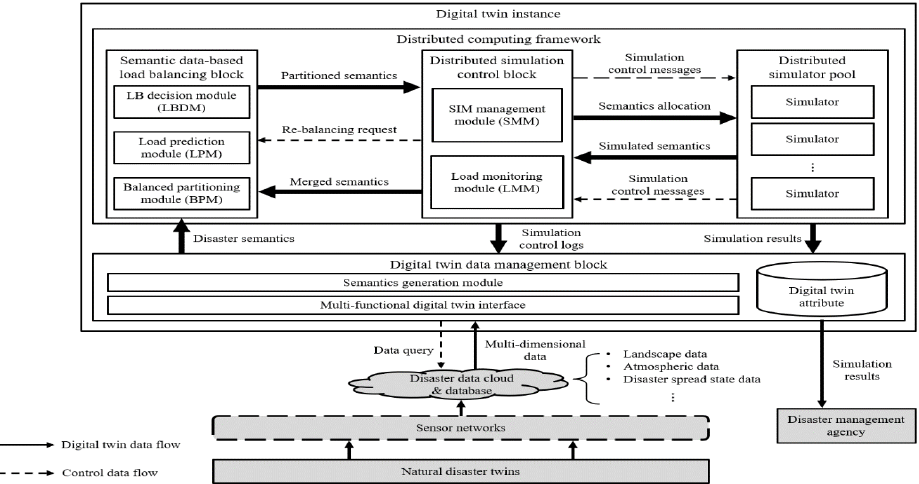
Figure 1. The overview of the prediction service for disasters with the proposed distributed computing framework.